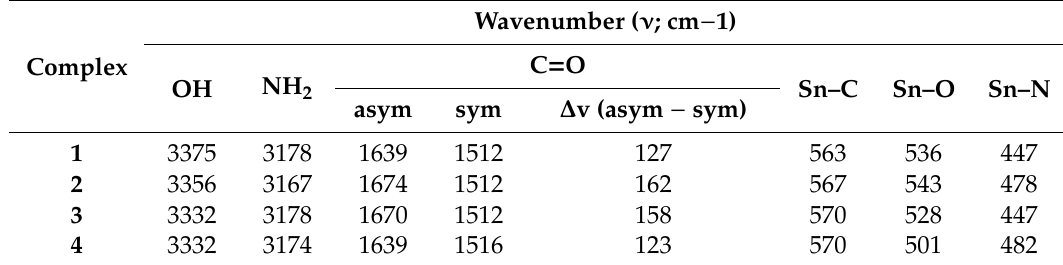
Table 2. Common FTIR absorption bands for complexes 1–4 .